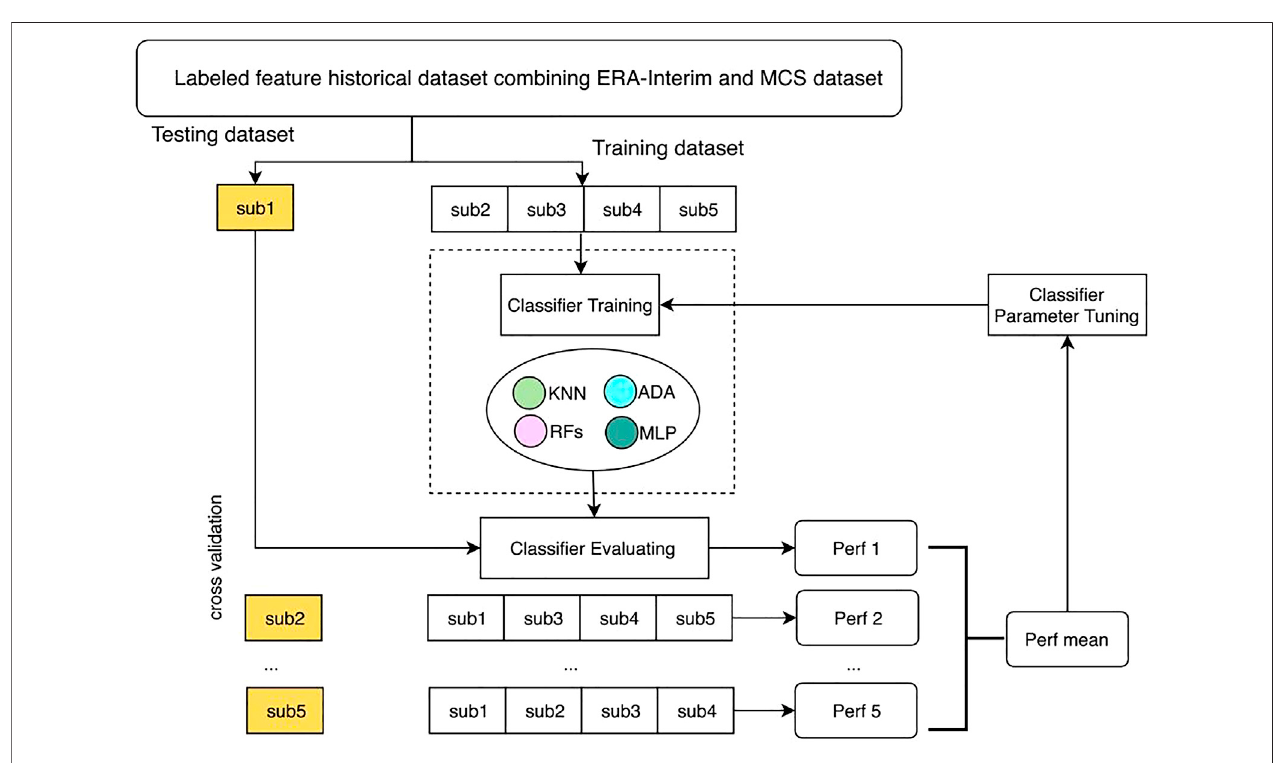
FIGURE 2 | Flow diagram of TC genesis prediction by using machine learning (Zhang et al., 2019).